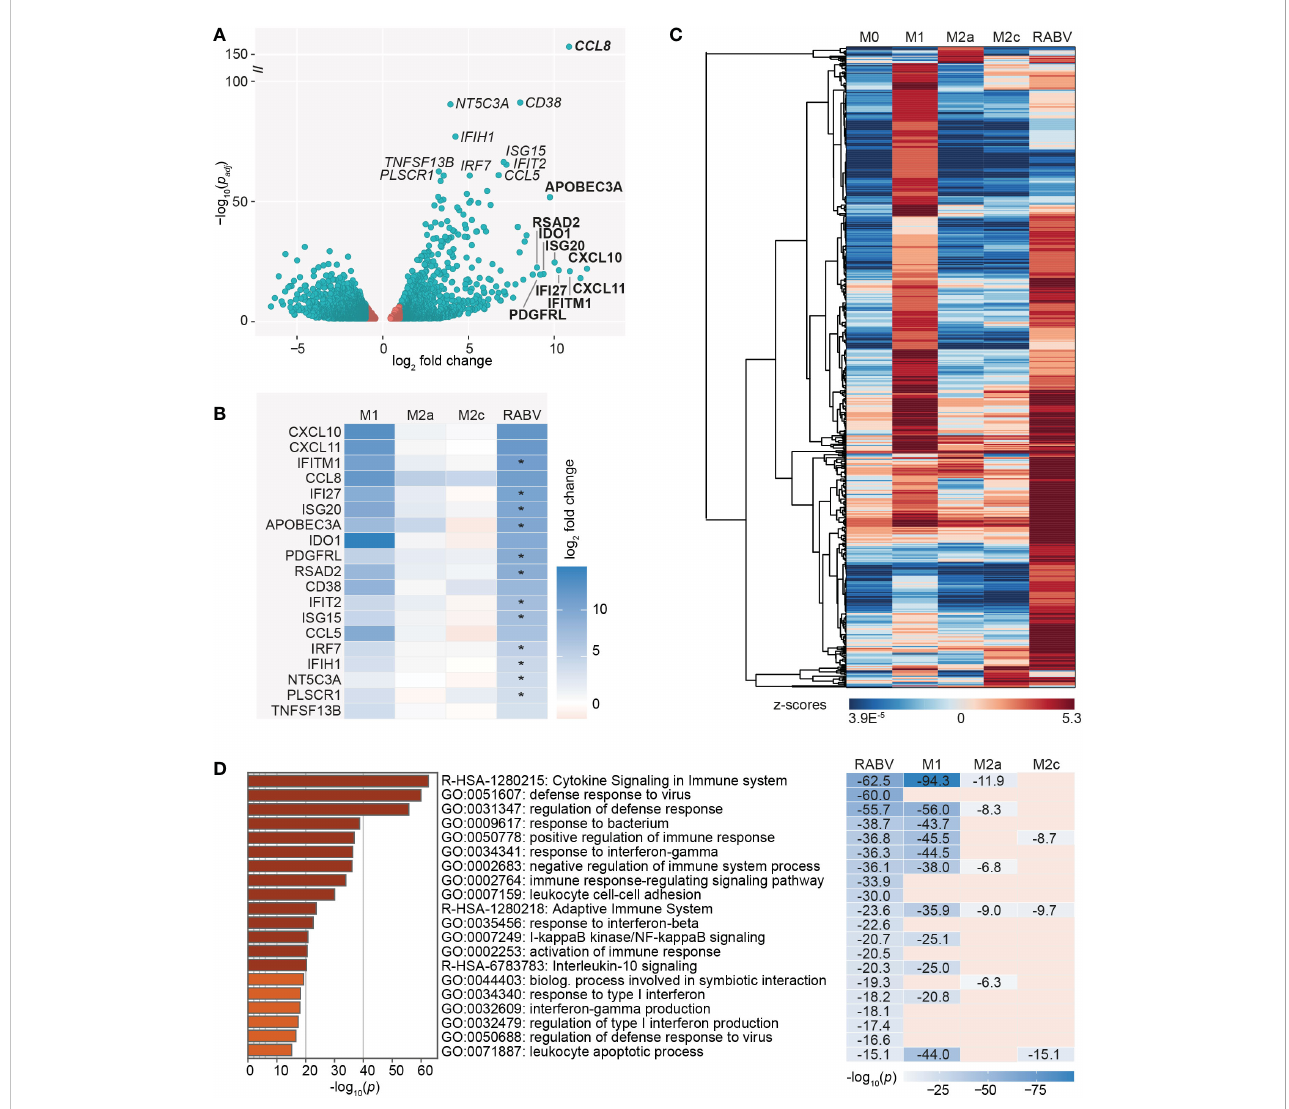
FIGURE 4 Visualization of the most signi fi cantly regulated genes of RABV-macrophages, and the induction of multiple virus response-related pathways. A volcano plot highlights the genes with the lowest adjusted p -value ( p adj , genes in italics) and the highest upregulation (log 2 fold change, genes in bold) of RABV macrophages compared to M0 macrophages (A) . Genes in red have a log 2 fold change between -1 and 1 and are not differentially expressed. Log 2 fold change in M1, M2a and M2c macrophages of the highlighted genes in (A) is shown in (B) . Asterisks (*) in B indicate that expression levels in RABV macrophages are signi fi cantly higher than in M1 macrophages. Clustering analysis (C) and pathway enrichment analysis (D) of the differentially and substantially expressed (RPKM > 0.5) genes of RABV macrophages. The top 20 induced pathways of RABV are compared to that of the other phenotypes, and p -values are shown if the speci fi ed pathway was present in the top 20 of the speci fi ed macrophage